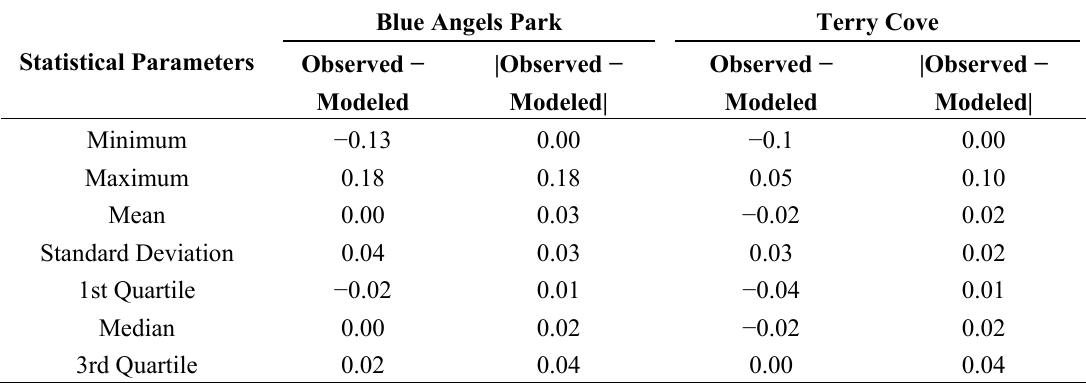
Table 2. Statistical summary of the differences (Observed − Modeled) and absolute differences (|Observed − Modeled|) between observed and modeled subtidal water surface elevations (m) at the monitoring stations Blue Angeles Park and Terry